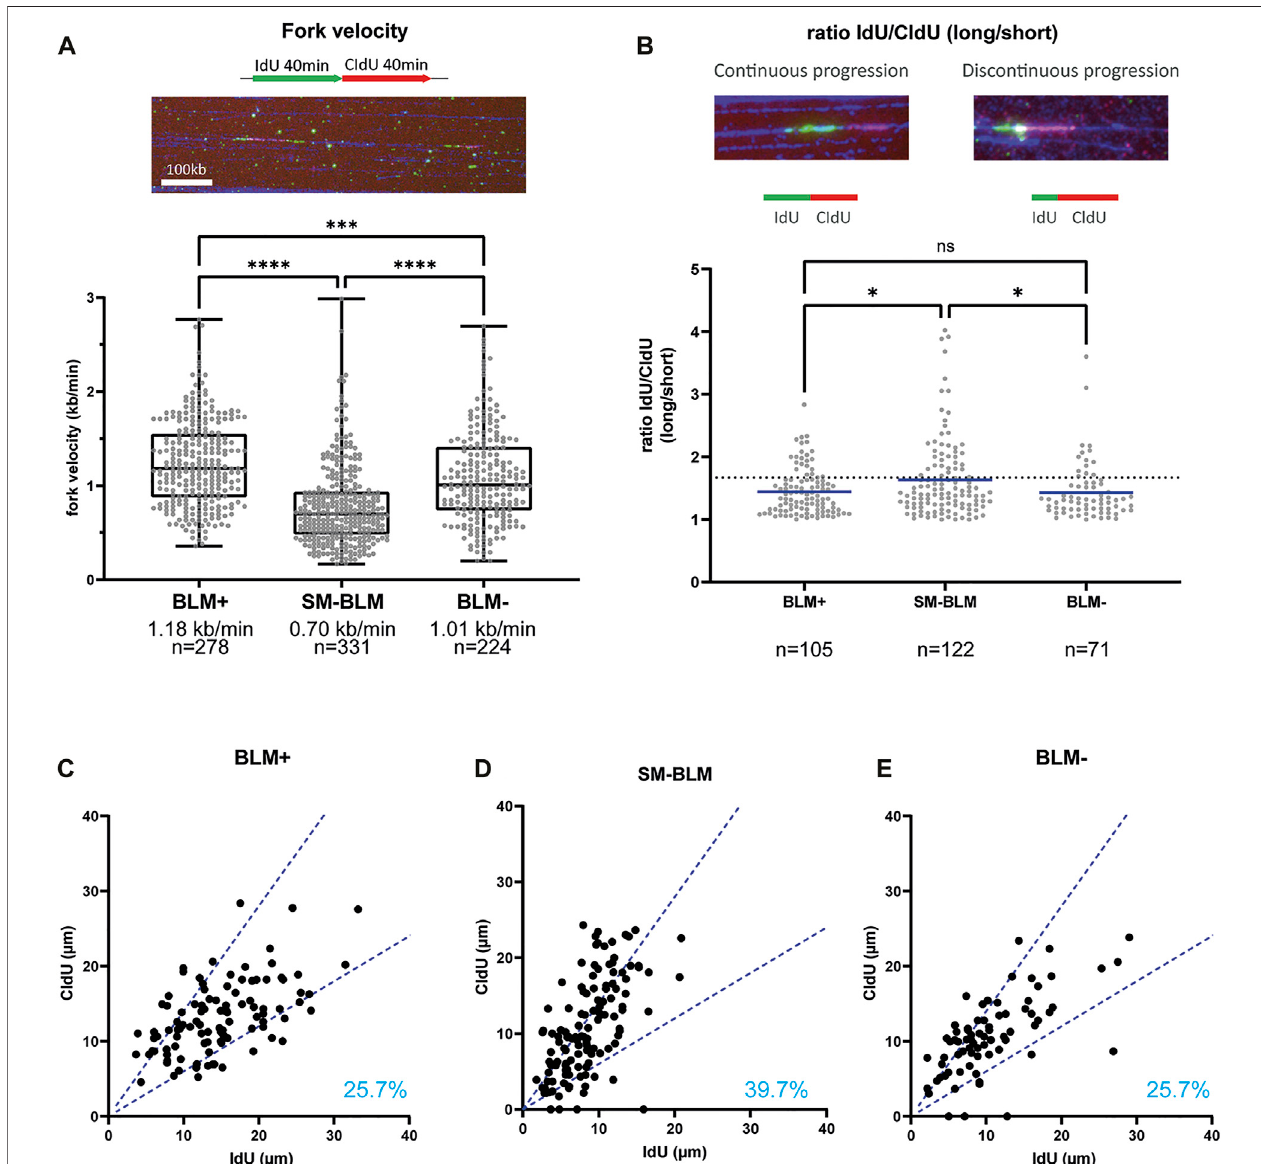
FIGURE 2 | SUMO-mutant BLM showed impaired replication fork progression. (A) Cells were labelled by two successive 40 min pulses of IdU and CldU. Intact replicationtracksasseeninthepictureweremeasured tocalculateforkvelocity.Thegraphshowsthedistributionofreplicationforkvelocitiesmeasured bymaRTAfrom two independent experiments. Box and whisker plots represent 25 – 75 percentiles and minimum and maximum values, respectively. Median fork velocity and total numberofsignalsisindicatedforeachcellline. (B) DistributionofIdU/CldUratioofactivereplicationforksfromtwoindependentexperiments.Ratiosareexpressed astheratiooflongertrackovertheshortertrack,regardlessofhalogenatednucleotideforwhichanexcessvaluewasobtained.Meanisindicated.Dottedlinerepresents 40%differencebetweenIdUandCldUlength.DatawasanalyzedusingMann-Whitneynon-parametrictest(ns,notsigni fi cant;*, p < 0.05;**, p < 0.01;***, p < 0.001;****, p < 0.0001). (C – E) Foreach active forkrepresented inB, lengthofIdU track wasplottedagainst length ofCldUtrack.Dotted bluelines indicate 40%difference between the two signals. Percentages indicate the percentage of asymmetric labeled track (forks that have more than 40% difference between IdU and CldU track lengths). Primary data are provided in Supplementary Data S1